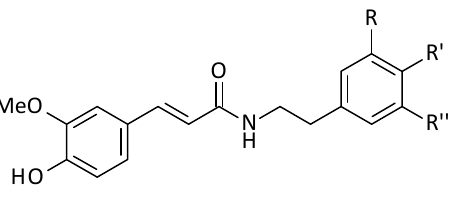
artefact formed during the isolation process as cis / trans isomerism is usually induced by light. However, natural existence of cis - and trans -isomers of various natural compounds is not uncommon. Tyramine and its derivatives have been shown to act on various bio- molecular targets (e.g., monoamine oxidase (MAO), α and β 1 adrenoreceptors), and thus to produce certain toxicological effects such as migraine and hypertension [19,20].